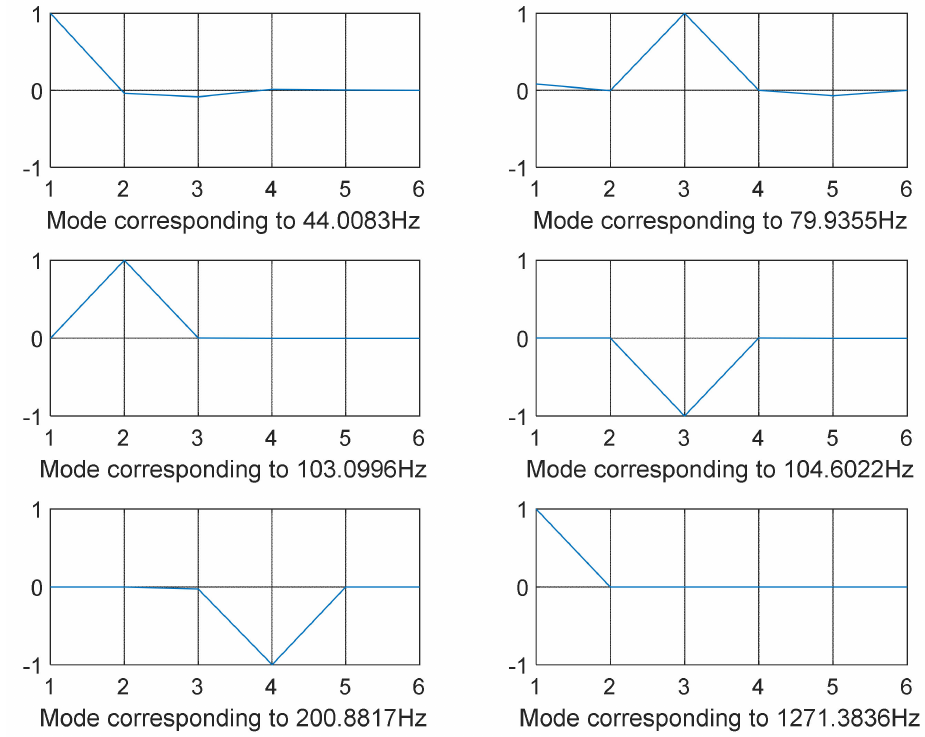
Figure 14. SQP-optimized mode shapes 7–12 (12-DOF model–combined